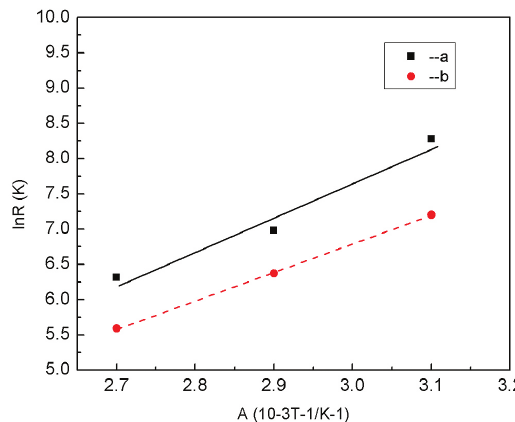
Figure 10. lnR-1/T